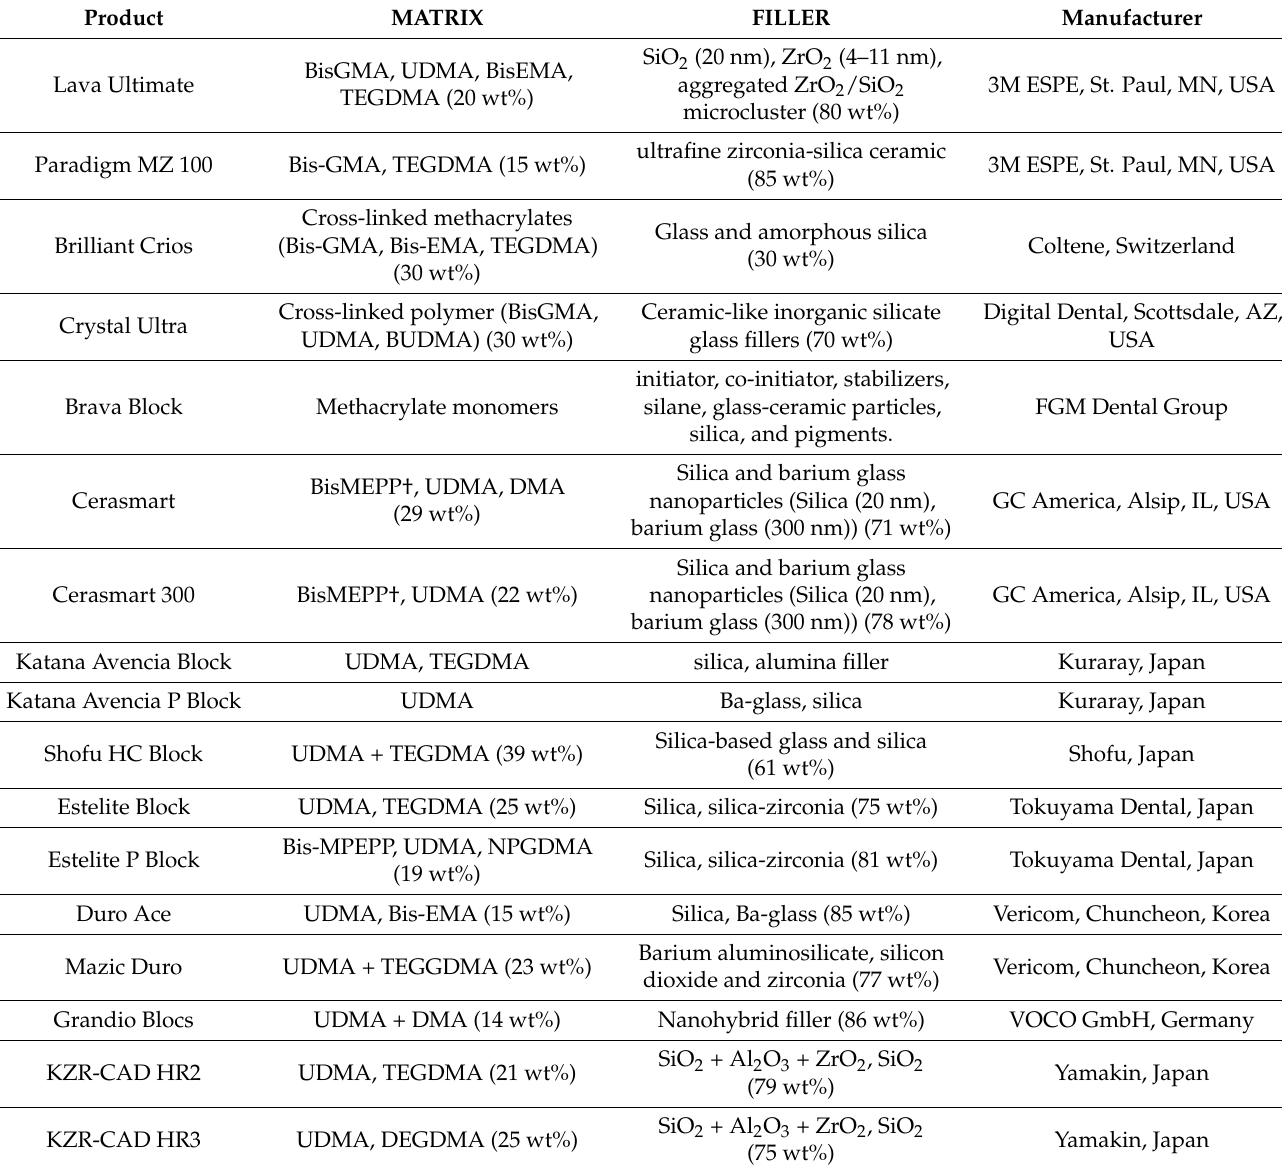
Table 2. Composition of CCBs investigated by papers included in current